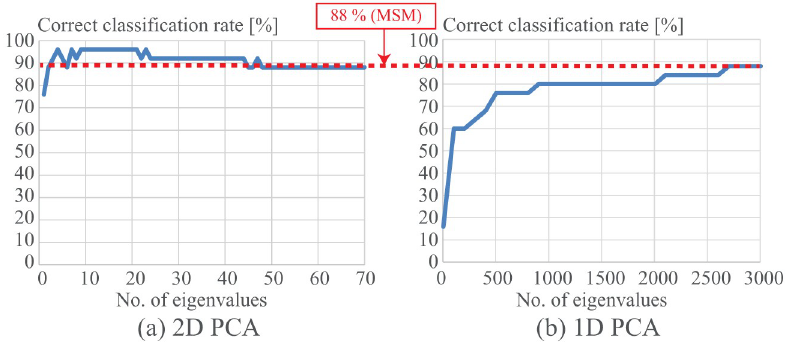
Fig 6. (a) Correct classification rate (CCR) with respect to the change of the number of eigenvalues of 2D PCA and (b) CCR of the